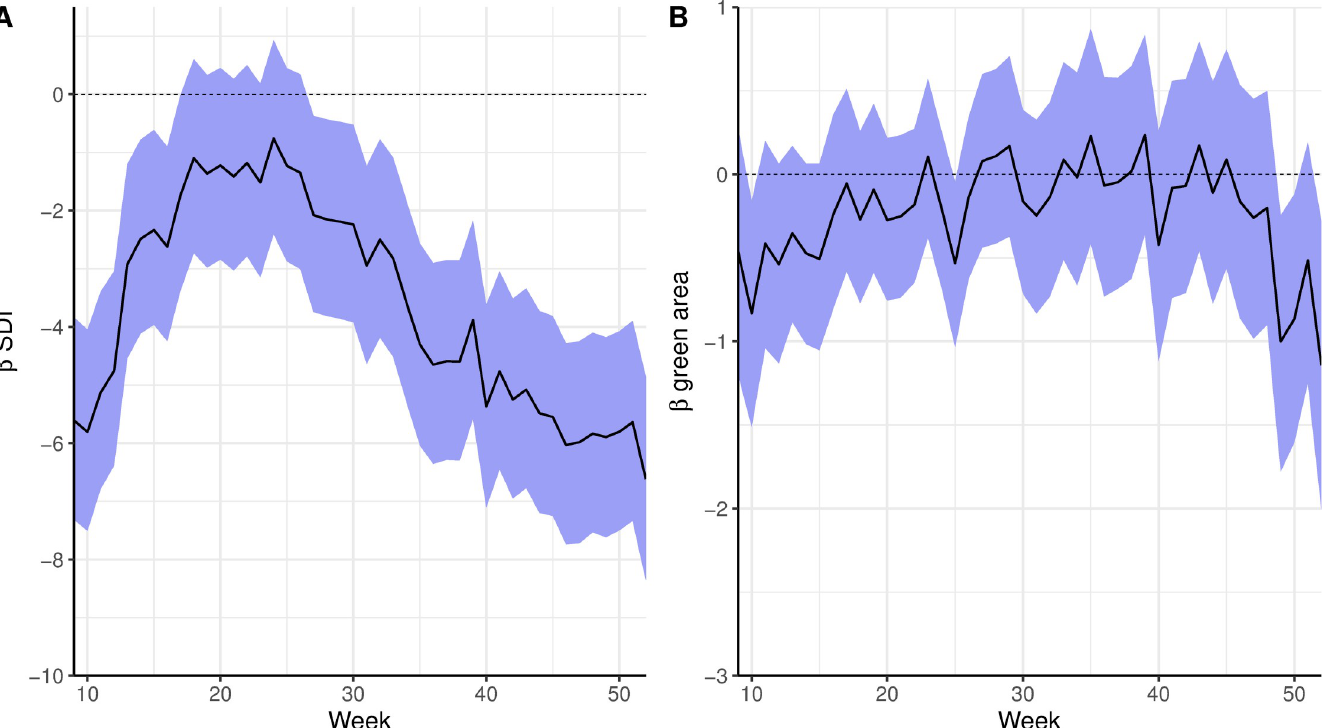
Fig 5. Time-varying coefficients (in the log scale, mean and 90% credible interval) for sociodevelopment index (SDI) (A) and proportion of green areas (B) for a spatial model for chikungunya cases from weeks 9 to 52 2016 and controlling for minimum temperature, Rio de Janeiro city, Brazil.